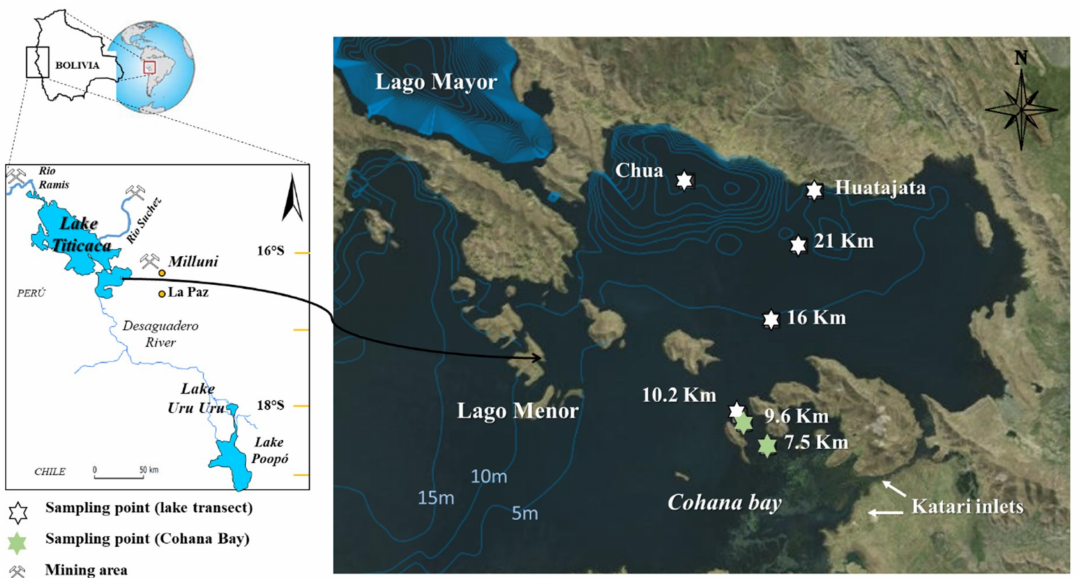
Figure 1. Sampling region showing both Lake Titicaca and Uru Uru (left panel) and a detailed map of the primary sampling stations in the southern basin of Lake Titicaca (LagFigo Menor) (right panel). White stars represent to sampling stations in the open waters of the lake along a transect with kilometric points starting from Huatajata station. Green stars refer to sampling stations in the Cohana Bay along a transect with kilometric points starting from the Katari river (wastewaters) inlet. Lines inside the lake represent 5 m isobathymetric lines (Adapted from a map generated at